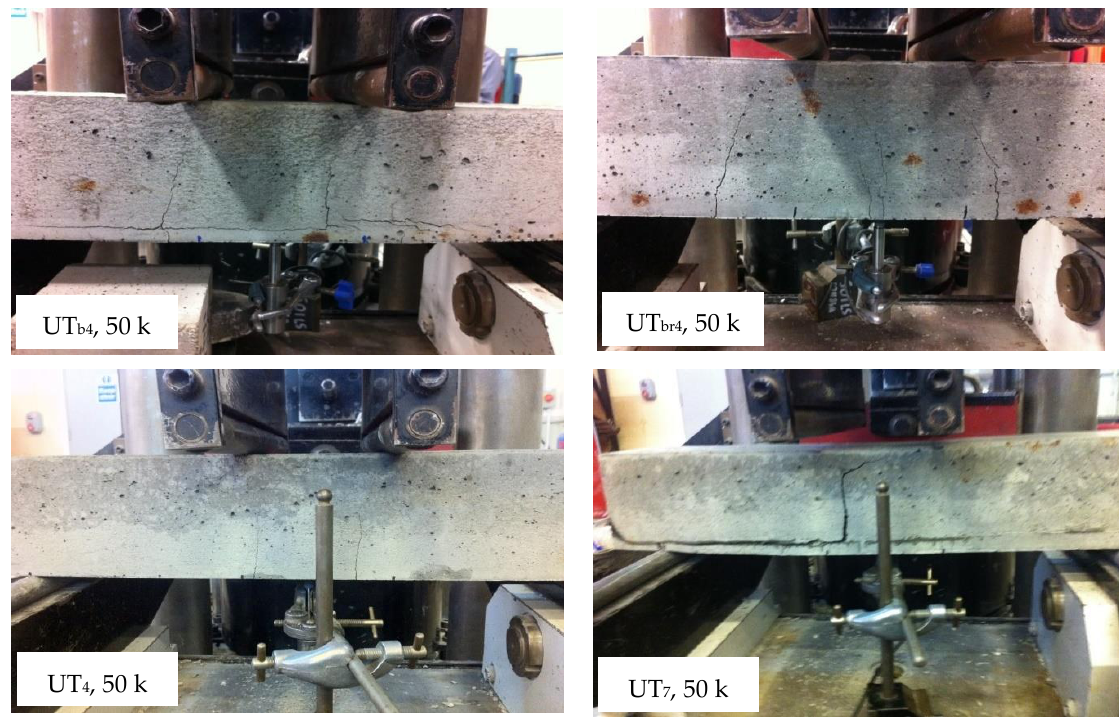
Figure 17. Cracks ’ patterns of uni-axial TRC beams. Figure 17. Cracks’ patterns of uni-axial TRC